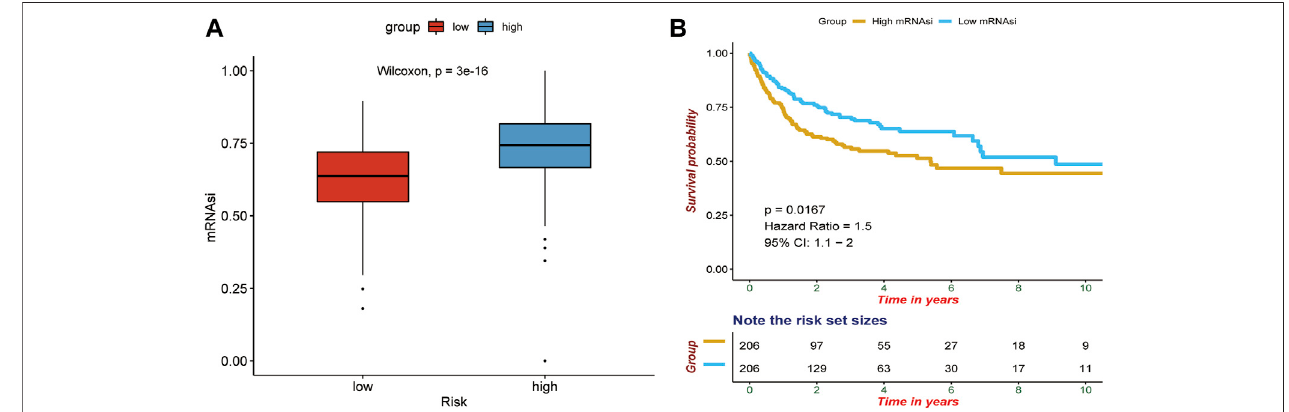
FIGURE 11 | Correlation between the gene signature and tumor stemness. (A) Differences of mRNAsi between high-risk and low-risk patients. (B) Survival difference between high-mRNAsi and low-mRNAsi. p -values were calculated with the log-rank